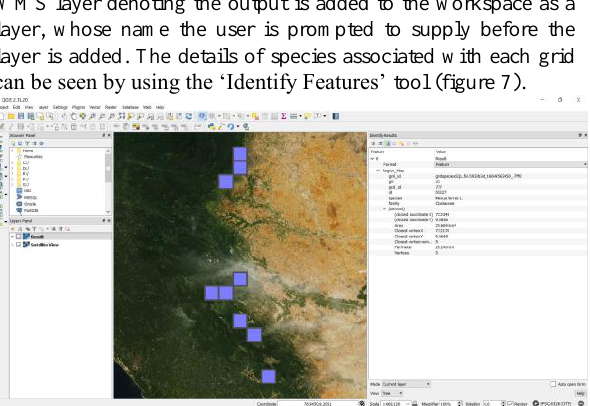
Figure 7. Executing IBIN Species Search WPS Service using Custom QGIS